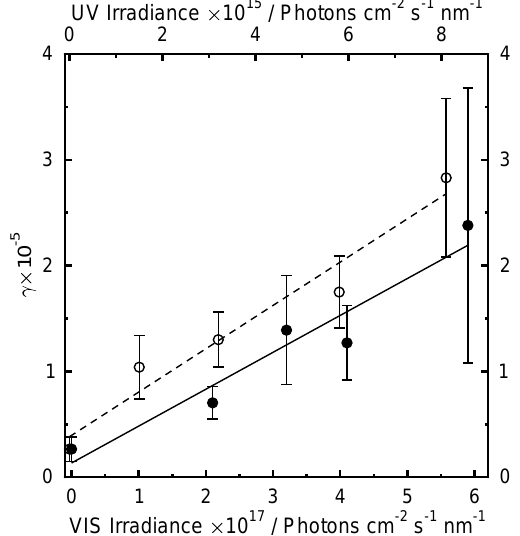
Fig. 7. Steady-state reactive uptake coefficients, γ , of the 1:1 by mass PP/NG substrate with O 3 as a function of photon flux shown as closed and open circles for exposure to VIS and UV irradiation, respectively. The open circles refer to the top x-axis. Errors bars denote 1 σ of the mean γ . Solid and dashed lines denote linear fits of the VIS and UV irradiated uptake data,